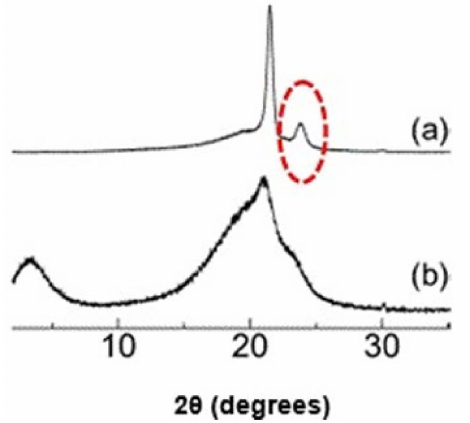
Figure 9. Patterns of X-ray diffraction: ( a ) polyethylene of low density, highlighting the peak of diffraction related to the plane (200) in 23 ◦ of orthorhombic crystals; ( b ) copolymer poly(ethylene-co- methacrylic acid) partially neutralized with Na + —ionomer EMAA − Na + . Adapted from Miwa, Kondo and Kutsumizu [29]. Reprinted with permission from Subnanoscopic Mapping of Glass Transition Temperature around Ionic Multiplets in Sodium-Neutralized Poly(ethylene-random-methacrylic acid) Ionomer. Yohei Miwa, Tomoyo Kondo, and Shoichi Kutsumizu. Macromolecules 2013 46 (13), 5232–5237. DOI: 10.1021/ma401035r. Copyright 2013 American Chemical